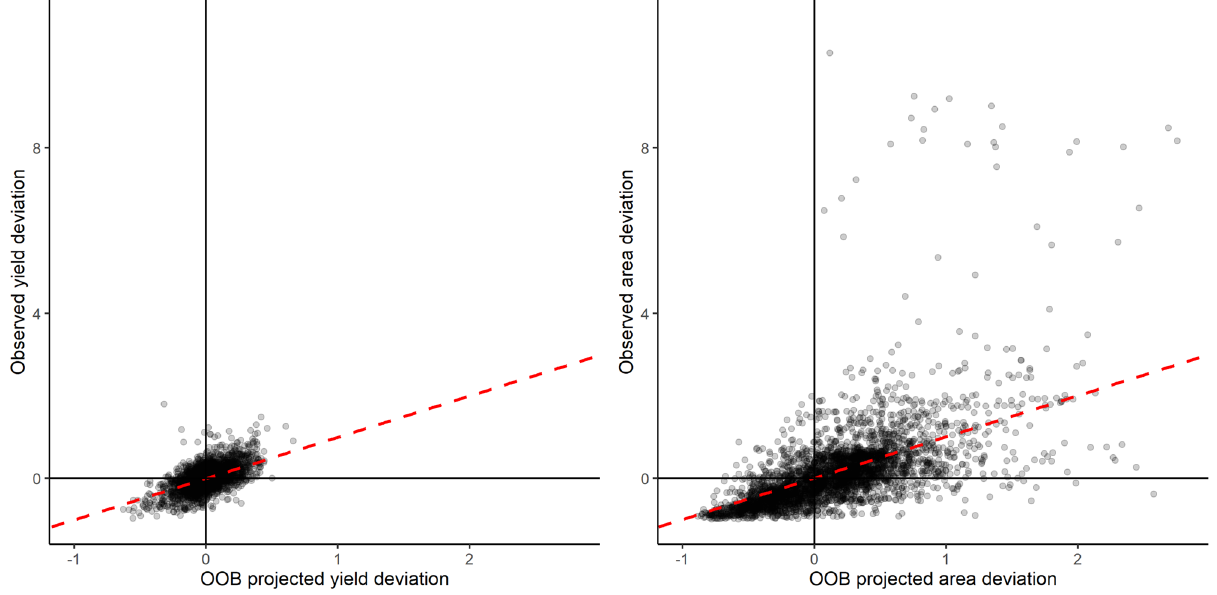
Figure 2. Random forest model projected values with observed yield and area anomalies. Red dashed lines have intercepts of 0 and slopes of 1.